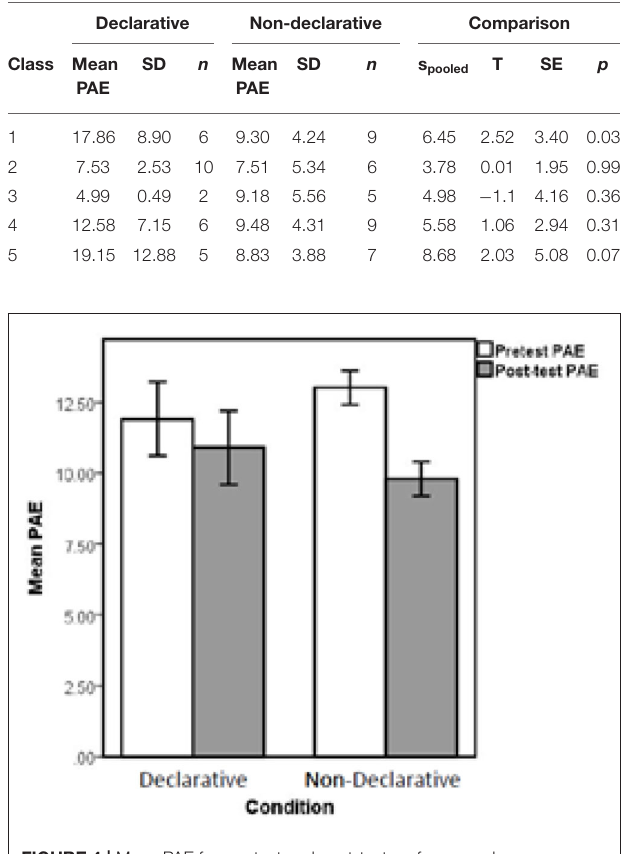
FIGURE 4 | Mean PAE for pre-test and post-test performance by experimental